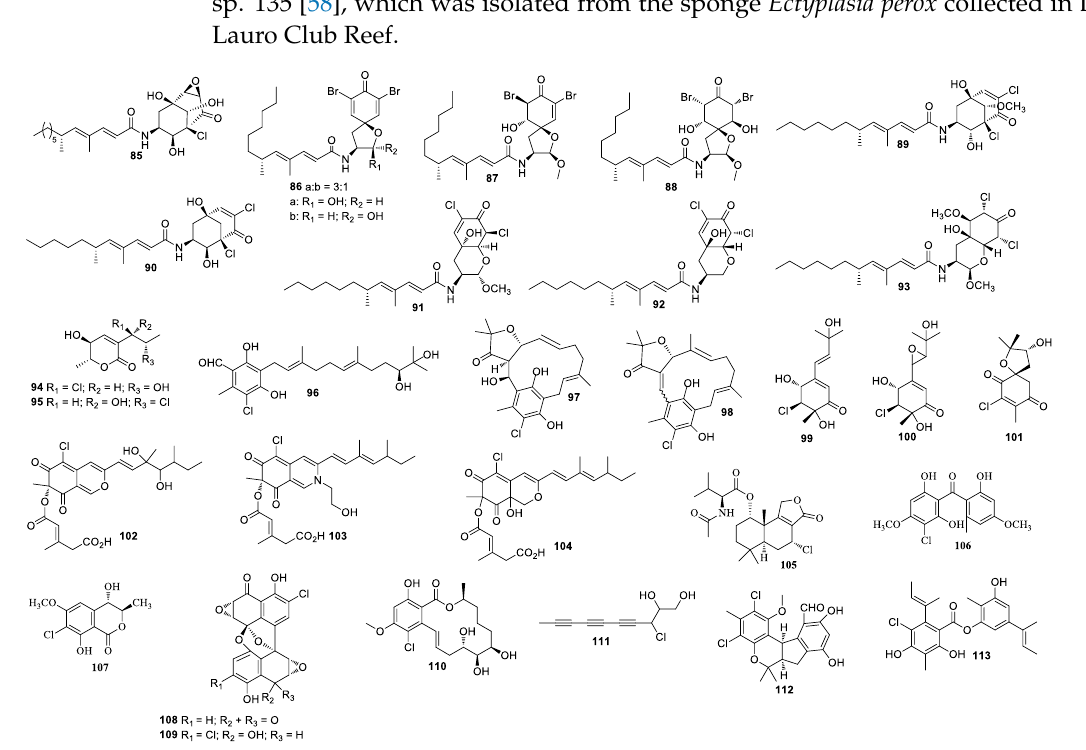
Figure 3. Structures of compounds 85 – 113.